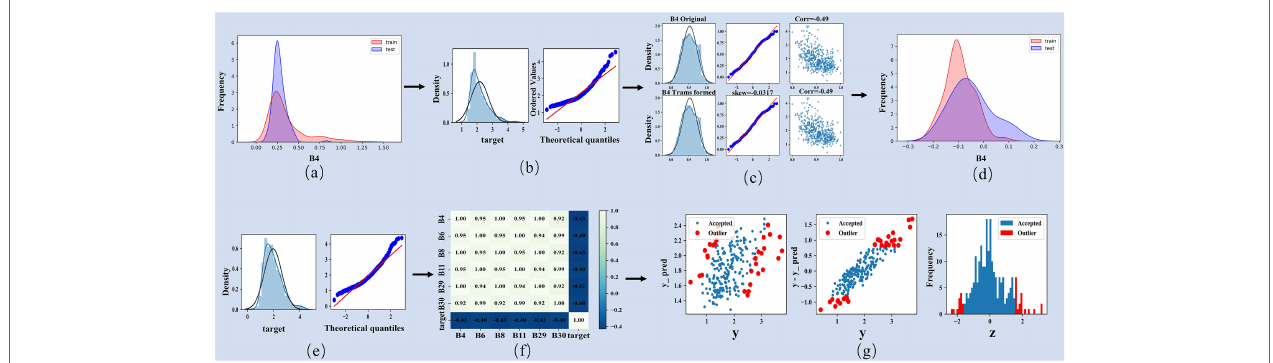
FIGURE 4 | Processing process of four kinds of high-dimensional image datasets. (A, B) Normal distribution map and kernel density map representing unprocessed feature bands. (C) Indicates standardization and logarithmic transformation of feature bands that do not conform to the normal distribution. (D, E) Indicates the normal distribution map and kernel density map of the processed feature bands. (F) Represents a graph of correlation coefficients between bands and between bands and target values (LAI). (G) represents the removal of